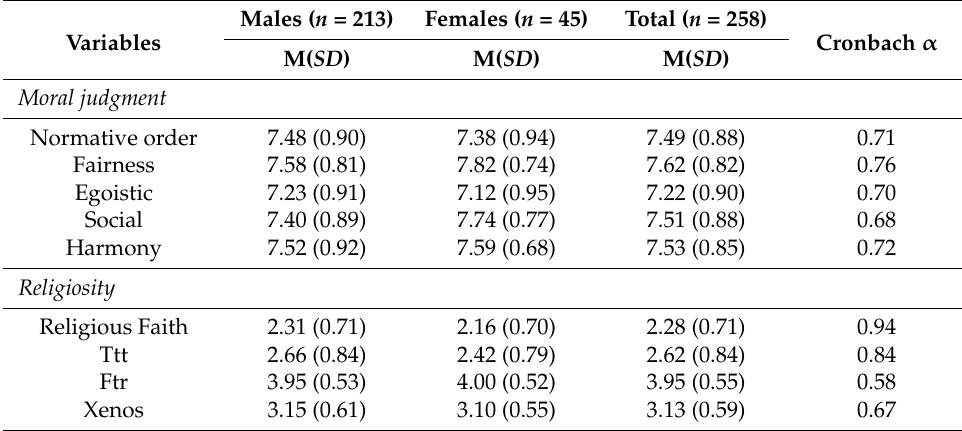
Table 1. Descriptive Statistics and Cronbach α for all variables.